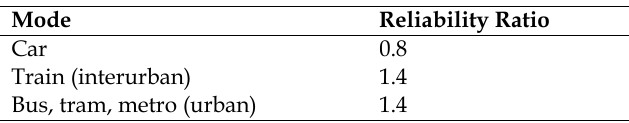
Table 1. Reliability Ratios for passenger transport by mode (purposes: commuting, business and